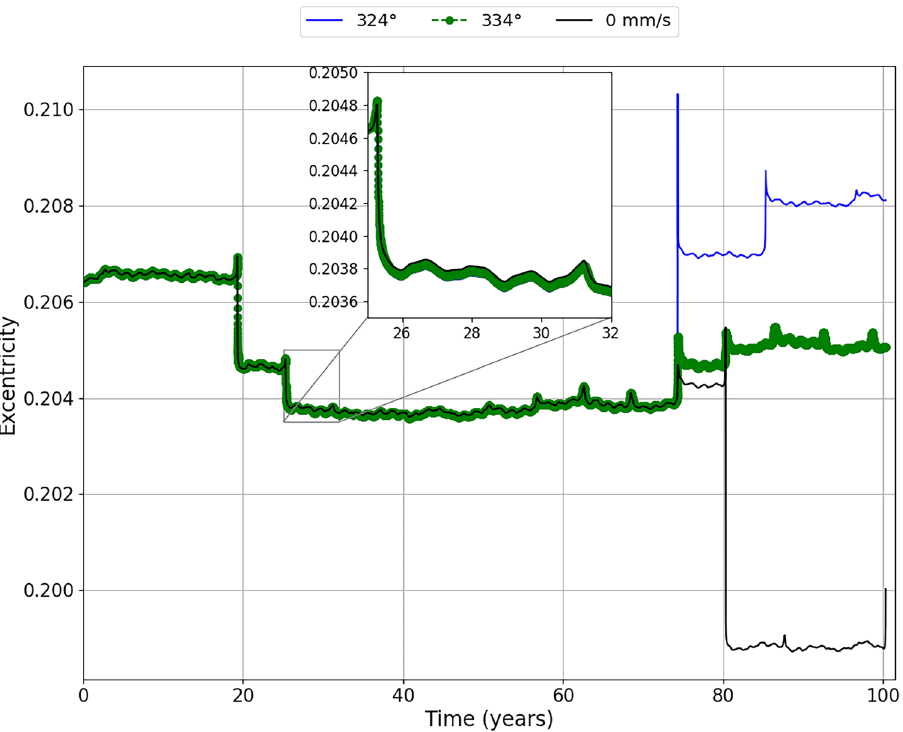
Figure 9. Evolution of eccentricity of the asteroid (e) over time for the impulse of −20 mm/s applied at the mean anomalies of 324° (blue line) and 334° (green line). We zoomed in on the region corresponding to the second largest close encounter to better visualize the variations in the eccentricity of the asteroid, since at this time the asteroid has significant variations in its relative distance from the